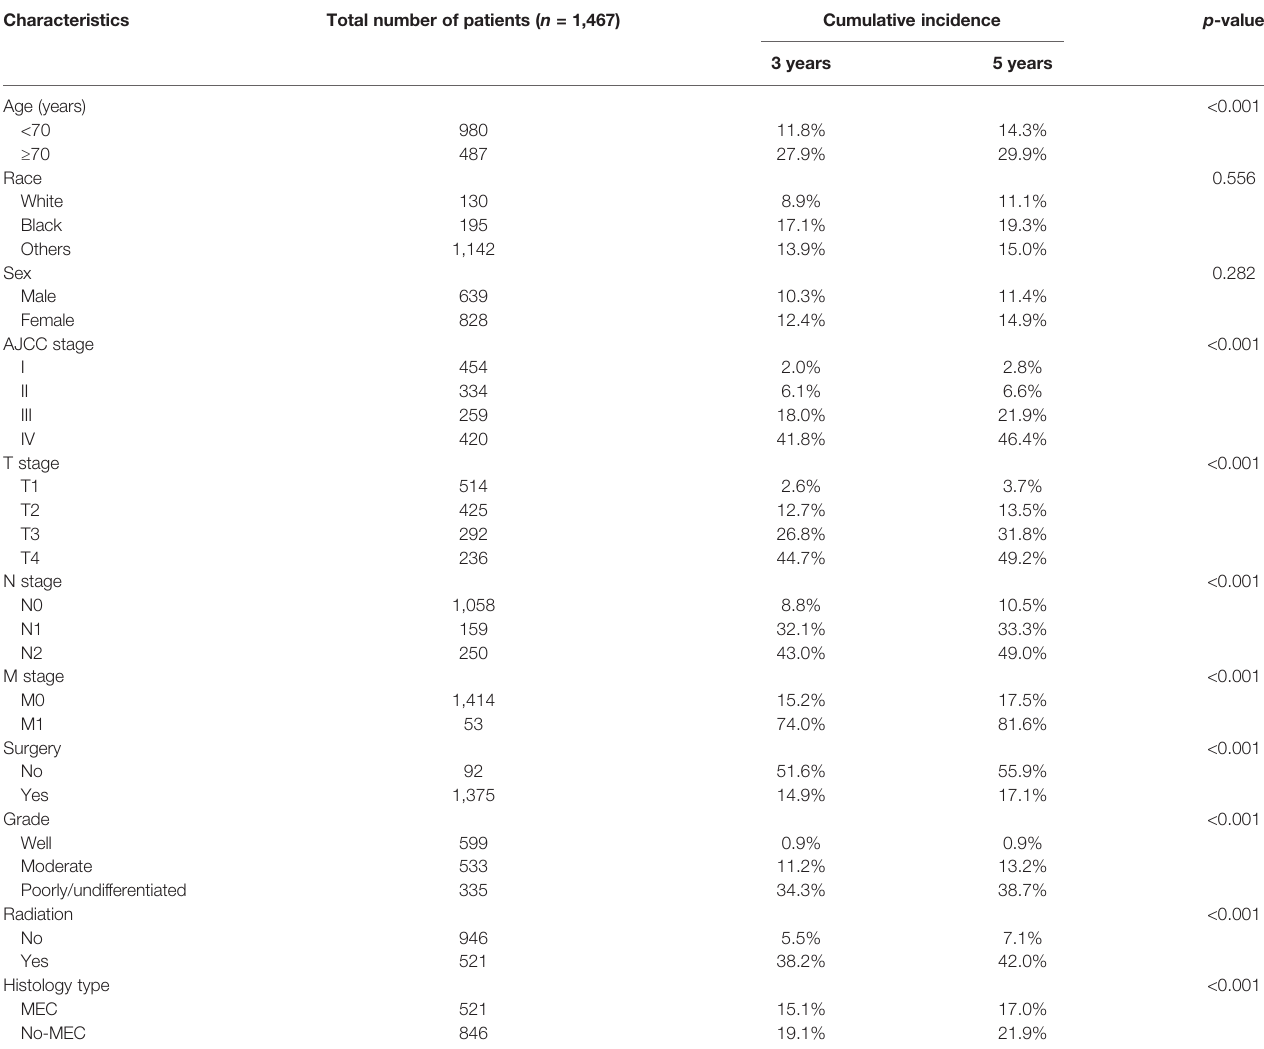
TABLE 2 | Cumulative incidence of cancer-speci fi c death in parotid cancer. Characteristics Total number of patients ( n =